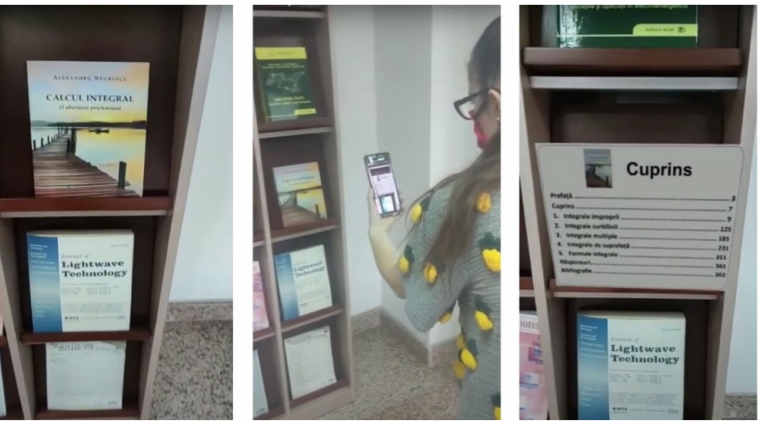
Figure 9. Piloting the augmented images functionality: a screen capture of the visitor’s phone, displaying the video stream acquired with the camera before identifying the book cover ( left ), a screenshot from an external video filming the real scene, and the visitor’s phone ( middle ), and a screen capture of the phone displaying the virtual image with the book’s table of contents superim- posed on the video stream from the phone’s camera ( right